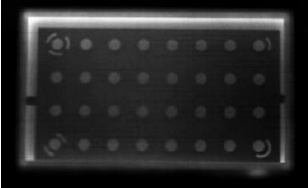
Figure 2. Thermal imagery for calibration